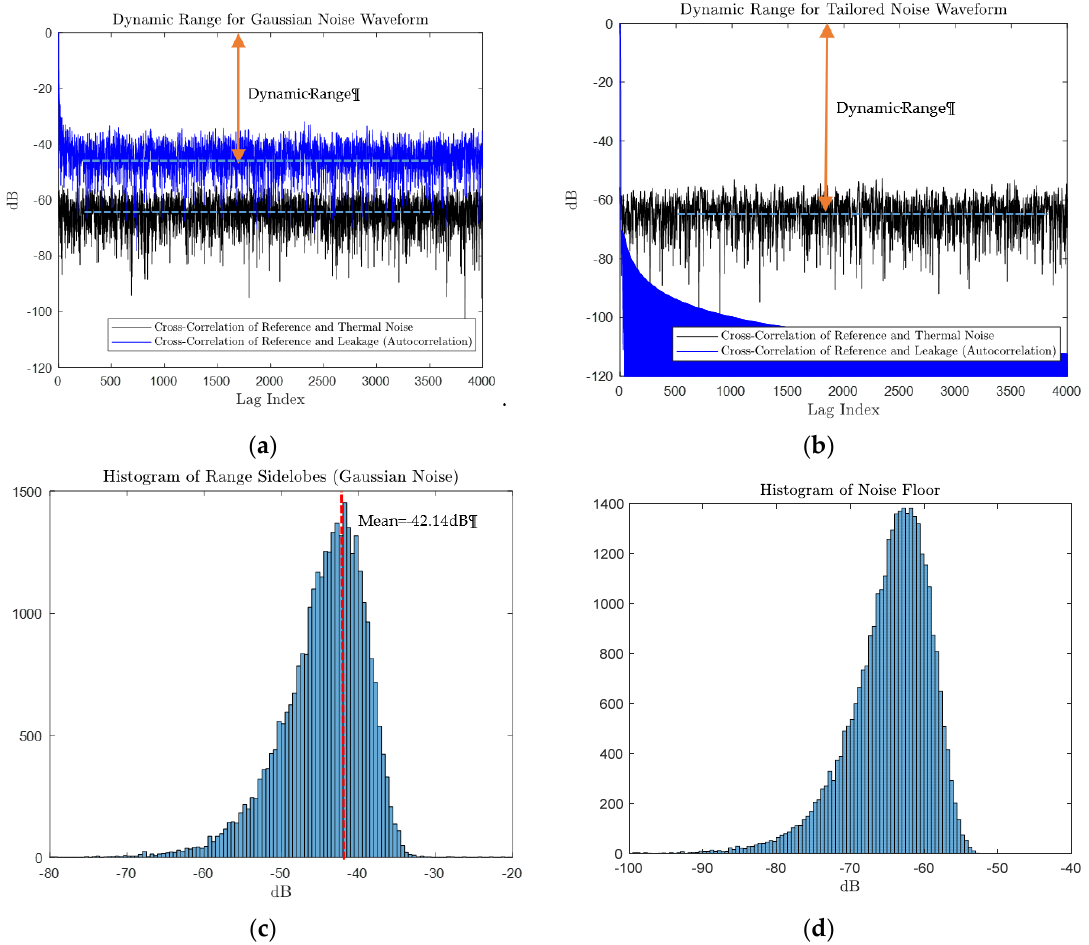
Figure 3. Illustration of dynamic range in noise radar. ( a ) Dynamic range is limited by waveform sidelobes. ( b ) Dynamic range is limited by noise floor. ( c ) Histogram of Gaussian noise range sidelobes in Figure 3a. ( d ) Histogram of correlation noise floor in Figure 3a.